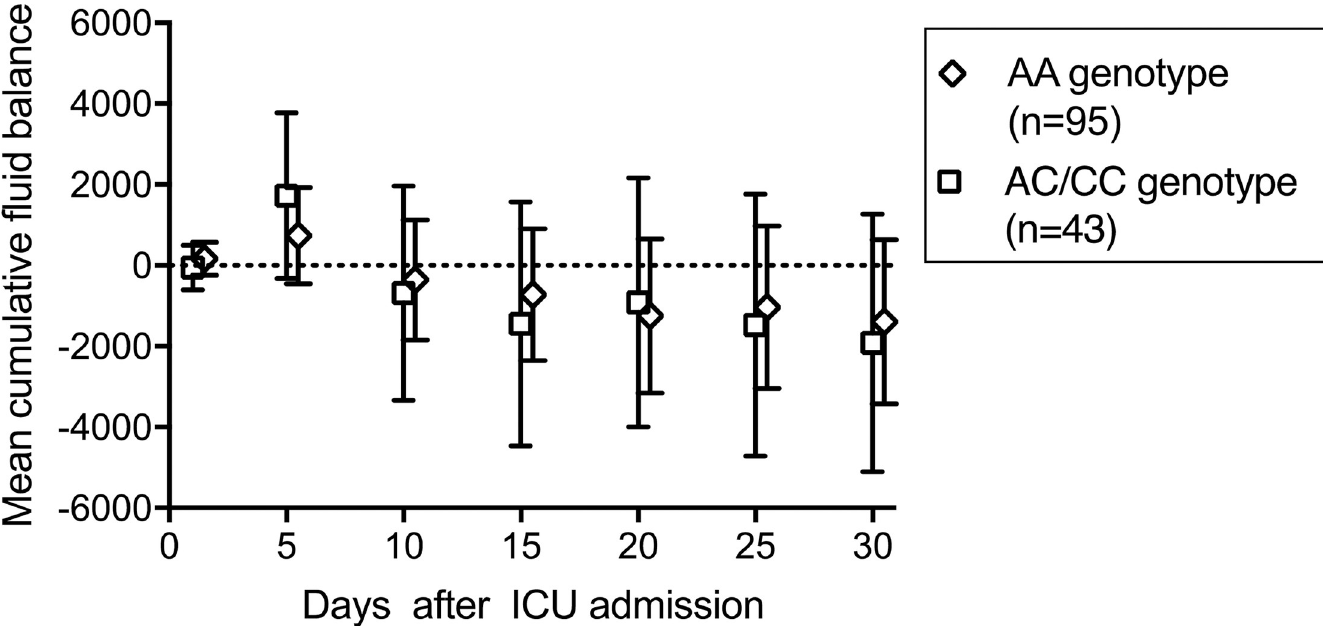
Fig 4. Mean cumulative fluid balances with 95% CI stratified for AA and AC/CC genotypes of the AQP5 -1364A/C promoter SNP until ICU day 30. The fluid balance showed no difference between the AQP5 genotypes.